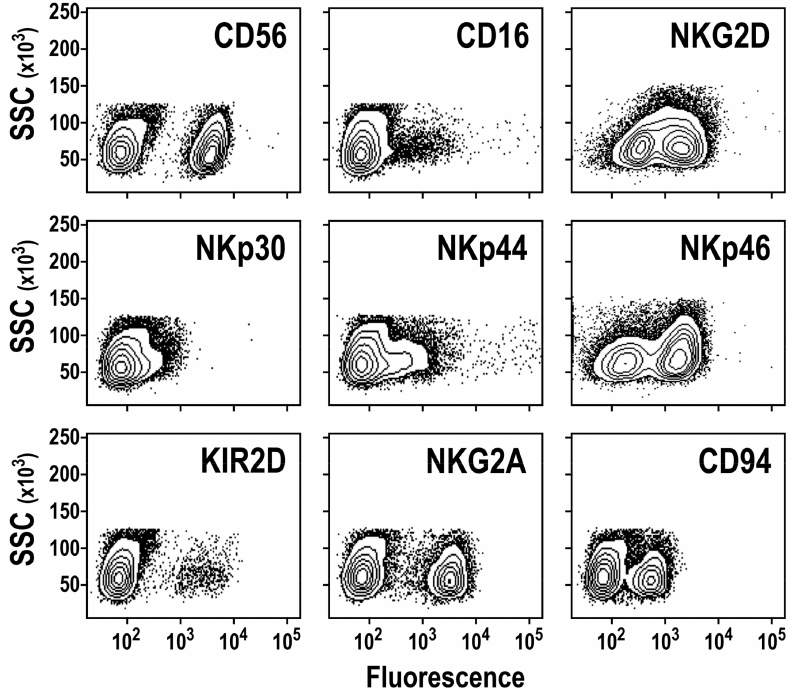
Figure 2. Phenotypic characterization of ex-vivo-generated CD56 + NK cells. Surface expression of NK-cell-associated activating receptors CD16, NKG2D and natural cytotoxicity receptors (NCRs; NKp30, NKp44, NKp46), inhibitory receptors NKG2A and CD94, and pan-KIR2D receptors (both activating and inhibitory) by CD56 + cells generated ex vivo from CD34 + cells was analyzed by flow cytometry after six to eight weeks of culture. Each plot is representative of at least five independent